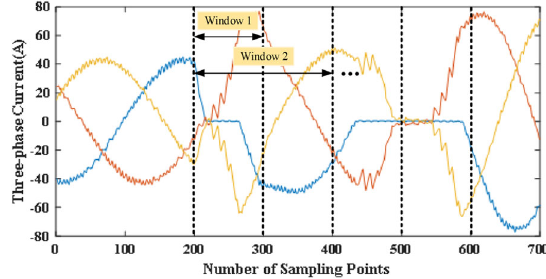
Fig. 7 The waveform when T 1 and T 4 are under open-circuit fault